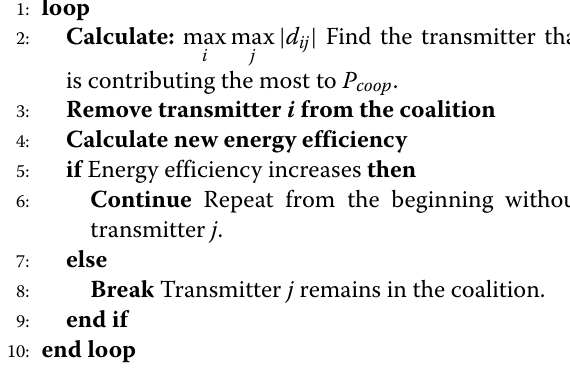
Algorithm 3 Greedy transmitter selection coalition for- mation (GCF) algorithm based on minimizing energy consumption and maximizing energy